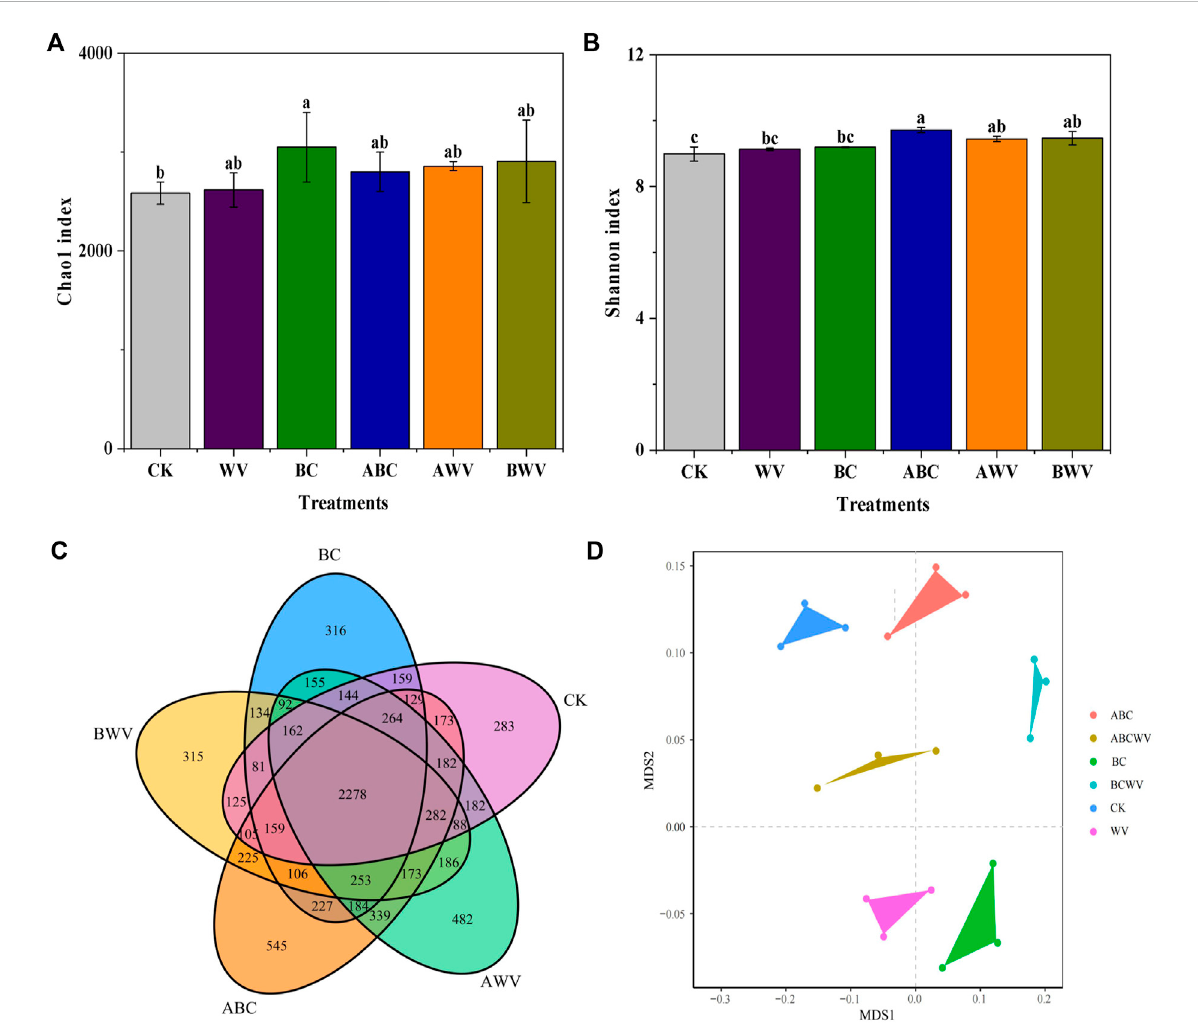
FIGURE 4 Pro fi les of the bacterial community in the coastal saline − alkali soil with different treatments. (A) Richness (Chao1) and (B) diversity (Shannon) index for the soil bacterial community. (C) Venn diagram showed the shared bacterial OTUs. (D) Non-metric multidimensional scaling (NMDS) ordination plots of the bacterial community composition based on the Bray − Curtis